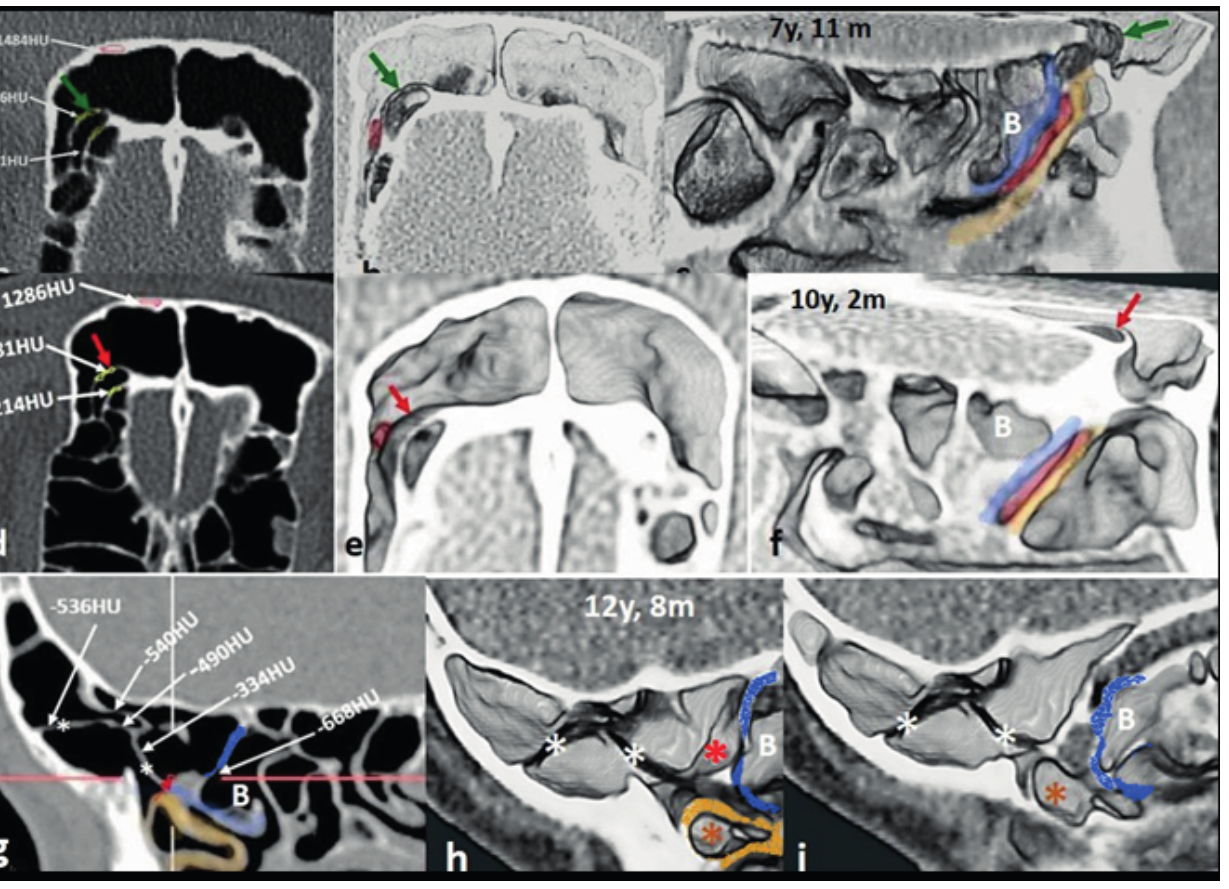
Figure 7: The development of a fronto-ethmoidal space over a 27 months interval, & a fronto-ethmoidal/frontal bulla space in a 12 year-eight month old